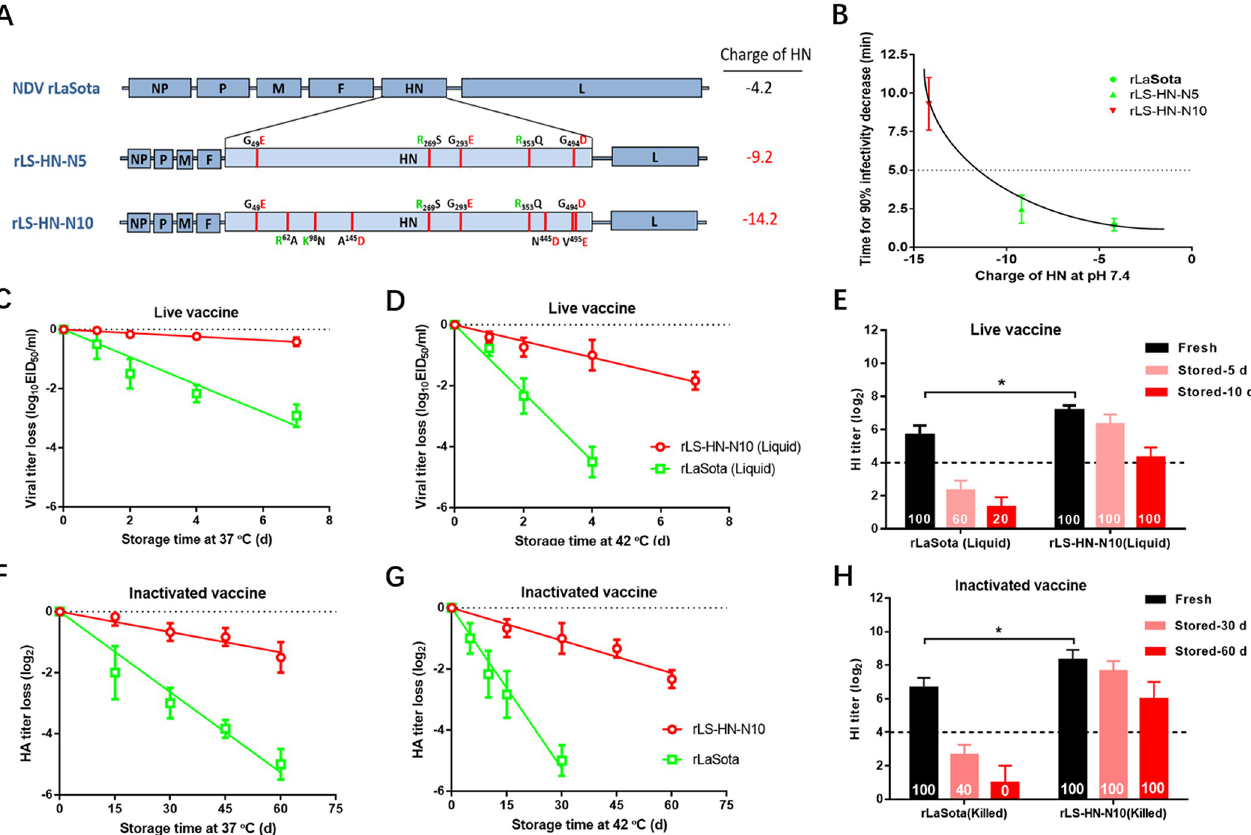
Fig 6. Improvement in the thermal stability of NDV LaSota vaccines by surface charge engineering. (A) Schematic representation showing the construction of recombinant NDVs with an enhanced negative charge of HN protein via introducing charge-associated amino acid mutations. (B) Scatter diagram showing the relationship between thermostability of rNDVs at 56˚C and their corresponding HN charge. (C, D) Heat-inactivation kinetics of infectivity of live NDV vaccines are determined at 37˚C (C) and 42˚C (D). The live liquid vaccines are prepared by diluting the allantoic fluids infected with rNDVs, to a final viral concentration of 10 7.0 EID 50 /ml with Tris-HCl (pH 7.8) containing 3% gelatin. (E) HI antibody response induced in chickens by live liquid NDV vaccines before or after storage at 37˚C. The birds are immunized with the indicated vaccines at a volume of 0.1 ml, and challenged with 10 5.0 EID 50 NDV strain F48E8 at 2 weeks post-vaccination. The protection rates are calculated and indicated at the bottom of bar. HI titers from each group are determined prior to the challenge (n = 5). (F, G) Heat-inactivation kinetics of HA activities of inactivated NDV vaccines are determined at 37˚C (F) and 42˚C (G). The inactivated vaccines are prepared by inactivating the allantoic fluids infected with rNDVs by using 0.05% BPL at 37˚C for 2 h, followed by diluting to 10 7.5 EID 50 /ml with Tris-HCl (pH 7.8). (H) HI antibody response induced in chickens by inactivated NDV vaccines before or after storage at 37˚C. The birds are immunized with the indicated vaccines at a volume of 0.5 ml, and challenged with 10 5.0 EID 50 NDV strain F48E8 at 4 weeks post-vaccination. The protection rates are calculated and indicated at the bottom of bar. HI titers from each group are determined prior to the challenge (n =